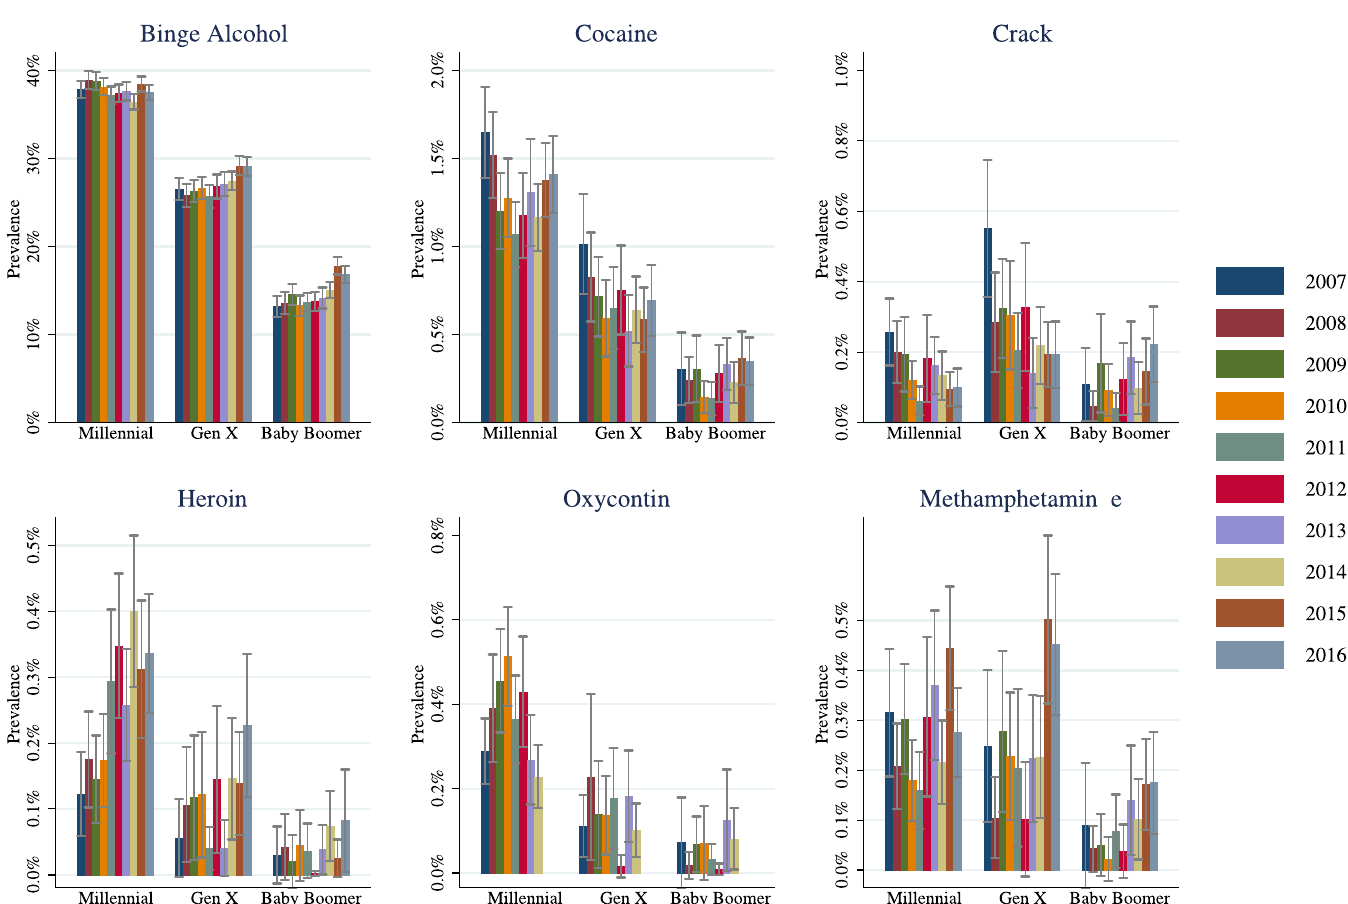
Fig 1. Prevalence of binge alcohol, cocaine, crack, oxycontin, heroin, and methamphetamine use by generational cohort, 2007–16. Error bars denote 95% confidence intervals.